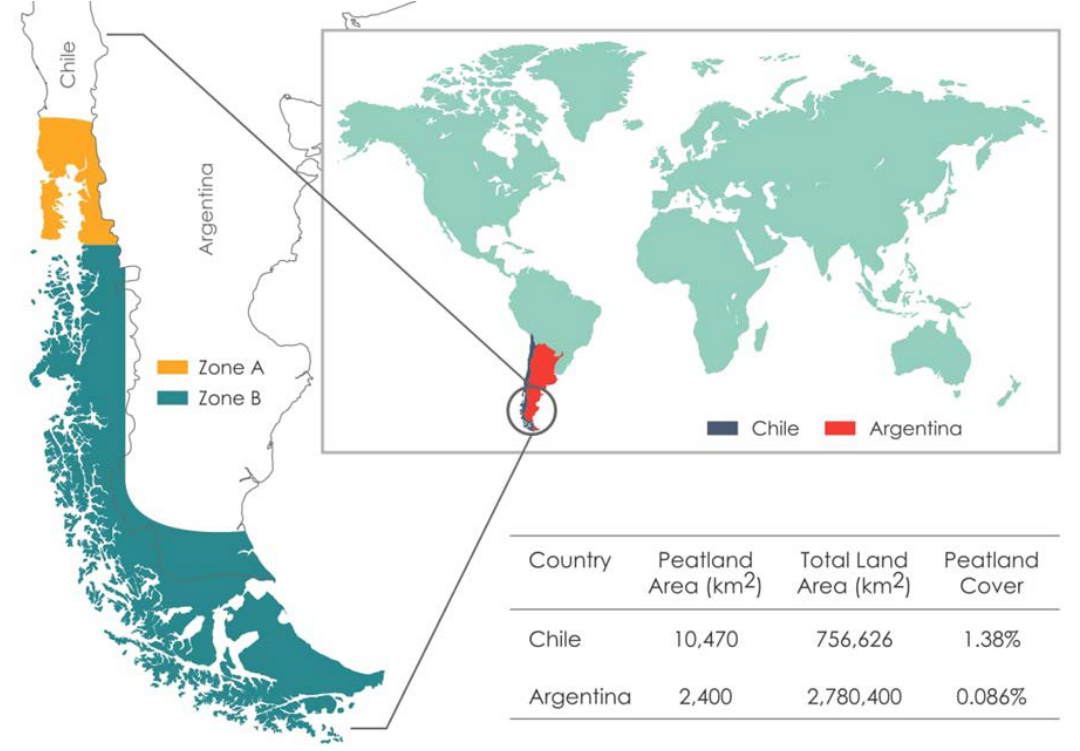
Figure 1. Main distribution of peatlands in Southern South America and area estimation in Chile and Argentina according to Rydin & Jeglum (2006). Zone A: scarce peatlands, located in depressions or high altitude areas, Zone B: abundant peatlands, located in varied